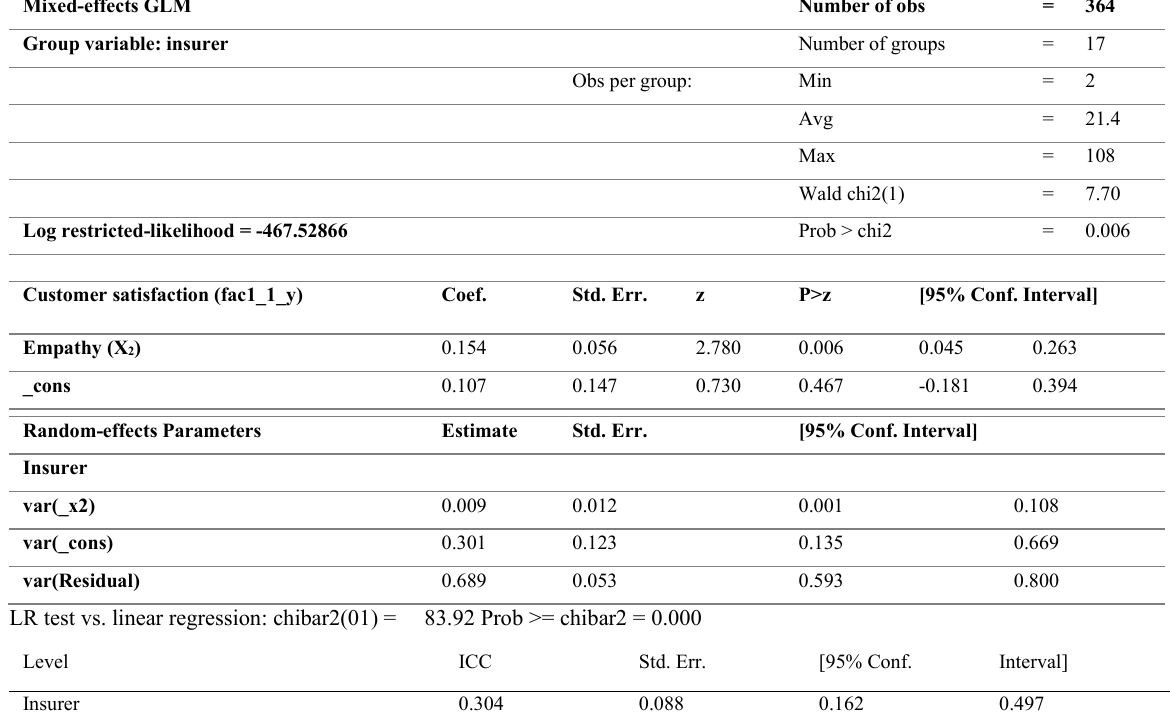
Table 7: Effect of Empathy: fixed effect with random